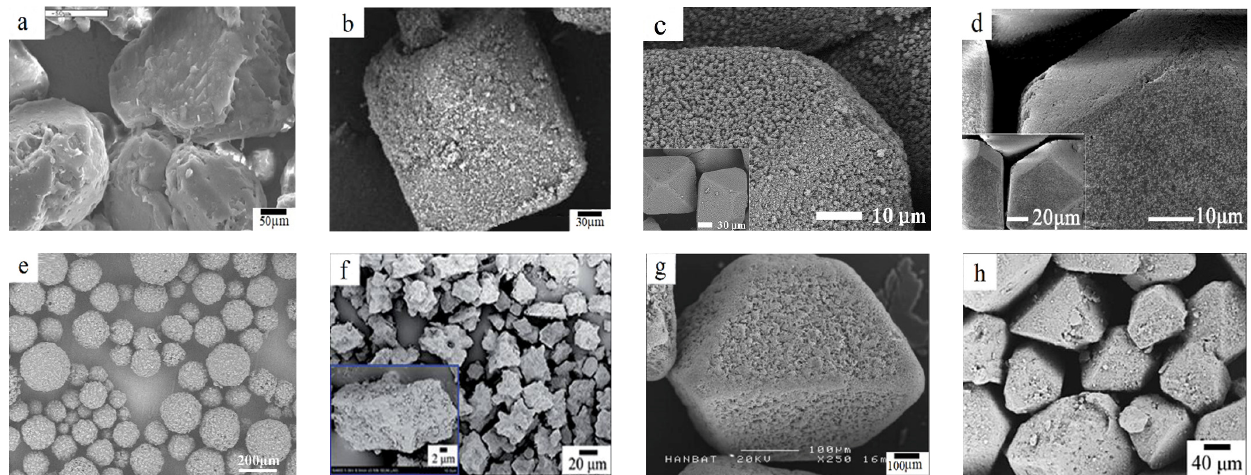
Figure 3. SEM images of some typical CSEs fabricated by different methods: ( a ) RDX@TNT/HP-1 via water suspension method; ( b ) CL-20@TATB via water suspension method; ( c ) HMX@MF via in situ polymerization technique; ( d )